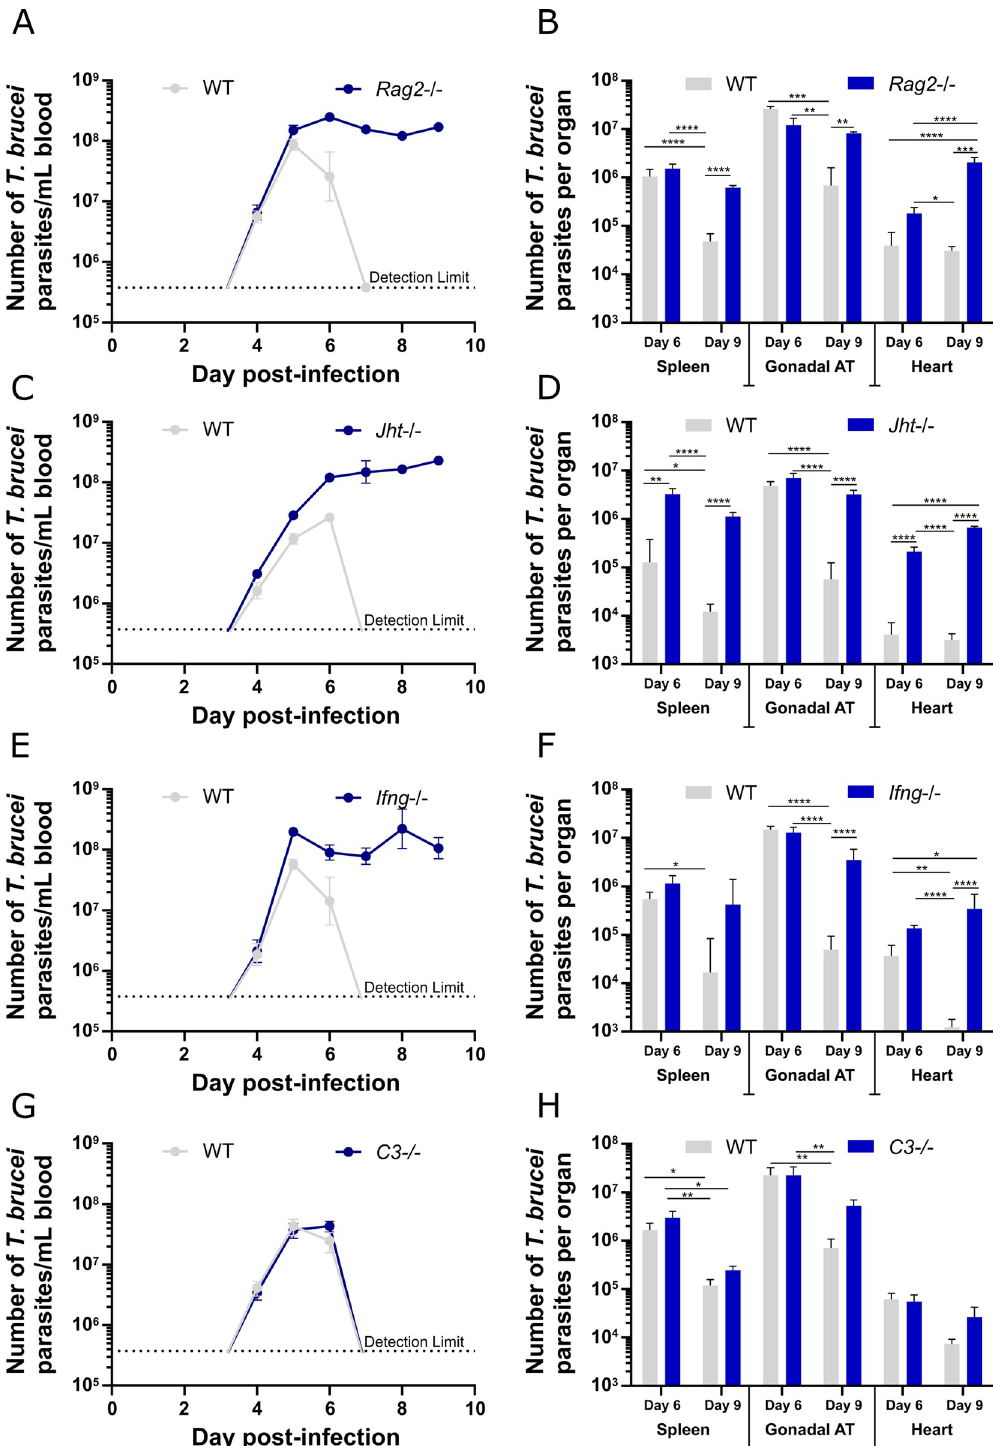
Fig 6. Assessment of the role of immune cells/factors in parasite control. Infection of WT and (A-B) Rag2 -/- , (C-D) Jht -/- , (E-F) Ifng -/- , (G-H) C3 -/- (A-H) Error bars represent the SEM (n = 3–7 mice per group). (Left) Parasitemia of mice infected with T . brucei , quantified in a hemocytometer. Dashed line represents the limit of detection (3.75x10 5 parasites/mL of blood). (Right) Number of T . brucei parasites quantified by qPCR in spleen, gonadal AT and heart, 6 and 9 days post-infection. Statistical analysis was performed with a two-way ANOVA using Sidak’s test for multiple comparisons. � , P < 0.05; �� , P < 0.01; ��� , P < 0.001; ���� , P < 0.0001. https://doi.org/10.1371/journal.ppat.1009933.g006 PLOS Pathogens| https://doi.org/10.1371/journal.ppat.1009933 September 15,